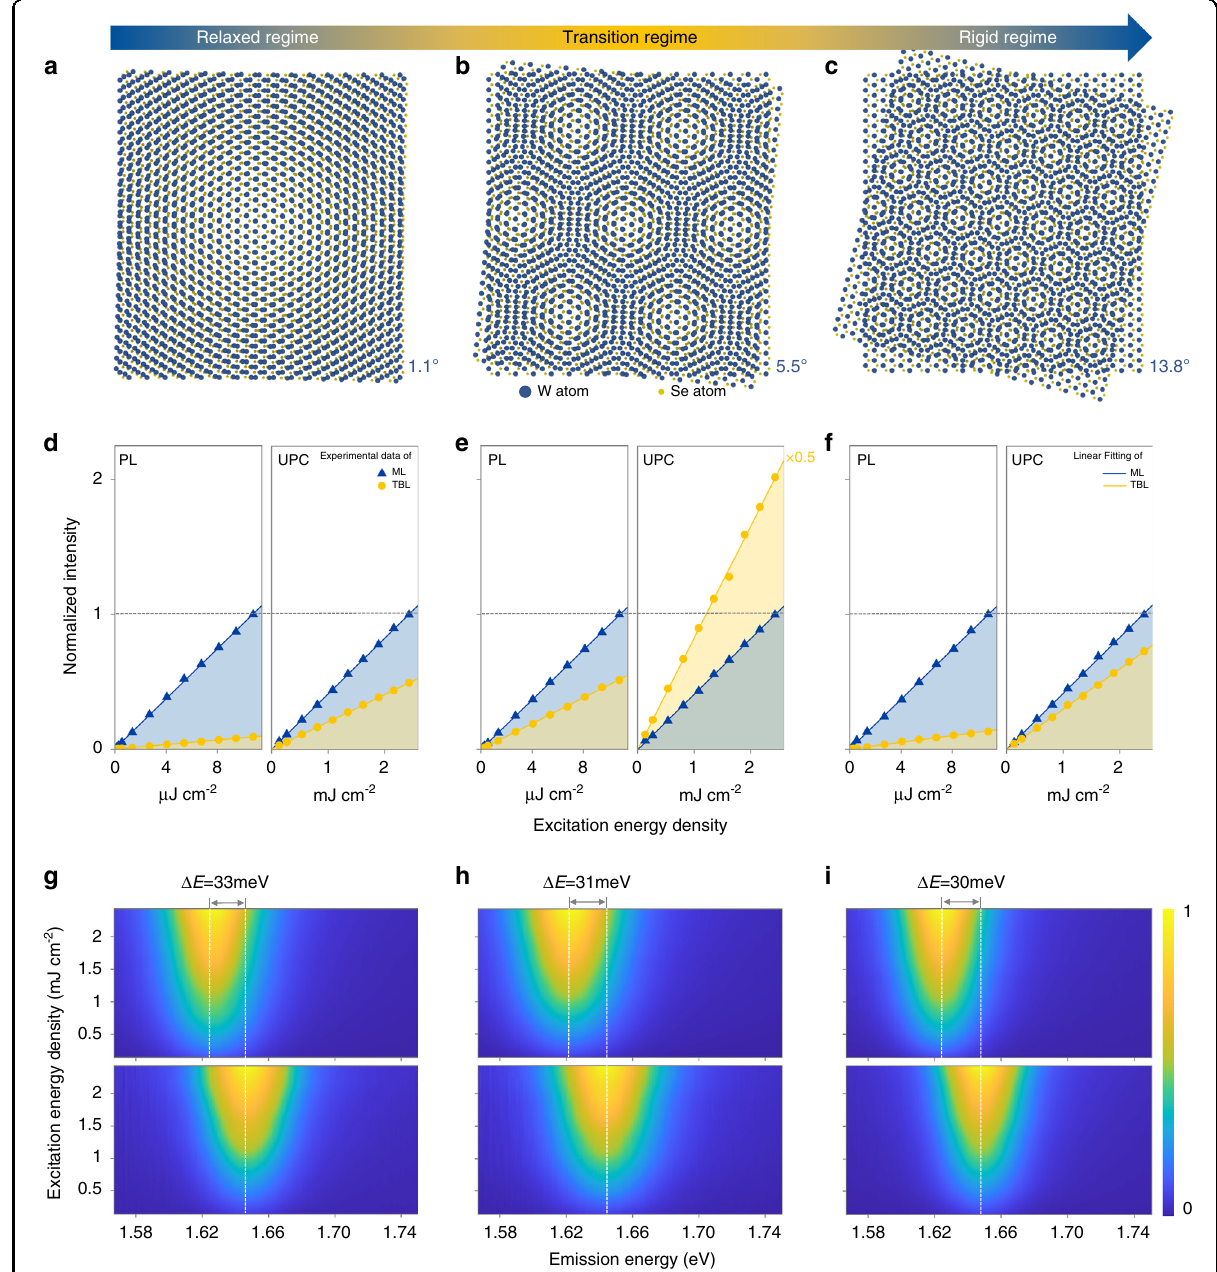
Fig. 3 Twist-angle-dependent UPC& PL in WSe 2 TBLs. a – c Schematic of WSe 2 twisted bilayer superlattices with rotation angles of 1.1° ( a ), 5.5° ( b ), and 13.8° ( c ). d – f Excitation-energy-density-dependent PL (left panels) and UPC (right panels) intensities plots of the 1.1° ( a ), 5.5° ( b ), 13.8° ( c ) WSe 2 TBLs (yellow dots), and corresponding MLs (blue triangles); the intensities of MLs at the highest excitation power are normalized as 1; the yellow and blue solid lines represent corresponding linear fi tting. g-i Excitation-energy-density-dependent UPC spectra of the 1.1° ( g ), 5.5° ( h ), 13.8° ( i ) WSe 2 TBLs (top panel), and corresponding MLs (bottom